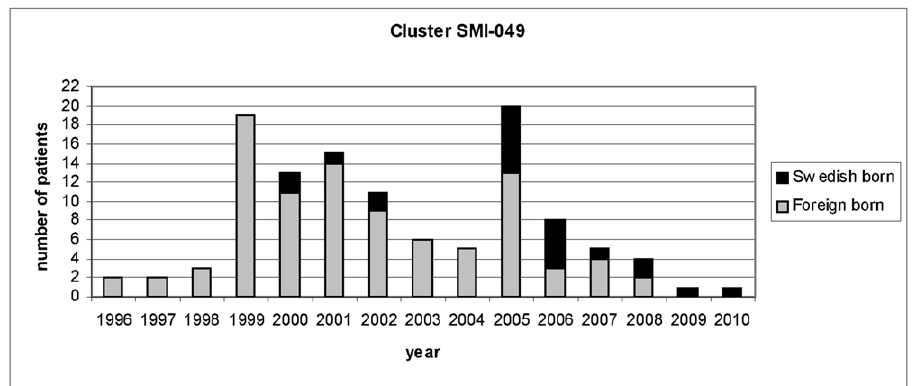
Figure 1. Number of new cases in cluster SMI-049 identified per year. The number of new cases belonging to the SMI-049 cluster is displayed for each year. Gray portions of bars represent foreign born patients, black portions of bars represent Swedish born